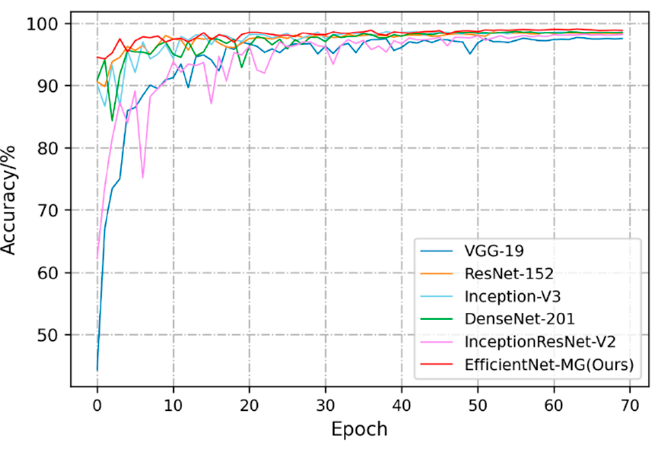
Figure 13. Convergence comparison of different CNN models.